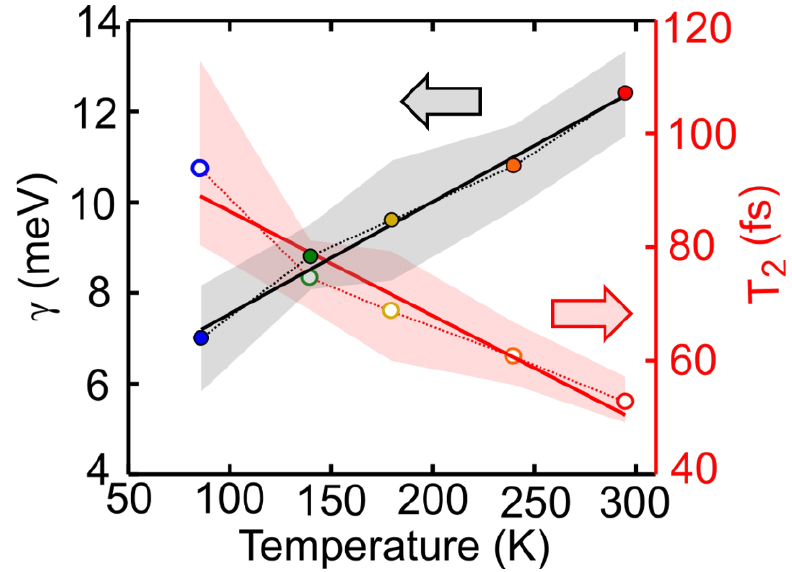
Figure 4. Homogeneous linewidth γ (black) and dephasing time T 2 (red) as a function of temperature. Symbols are the estimated values of γ and T 2 obtained from the best fit reported in Figure 3. The shaded areas reflect the error bar for each value of γ (dashed black line) and T 2 (dashed red line) which correspond to the standard deviation value obtained from the best fit. The black and red solid lines represent the linear fit to the